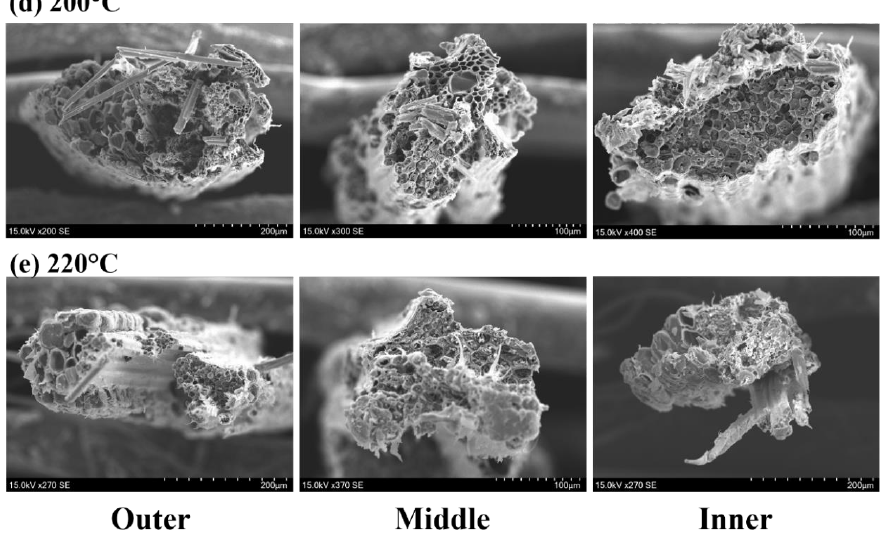
Figure 6. Overview of fracture surfaces in different areas in the radial direction with different tem-